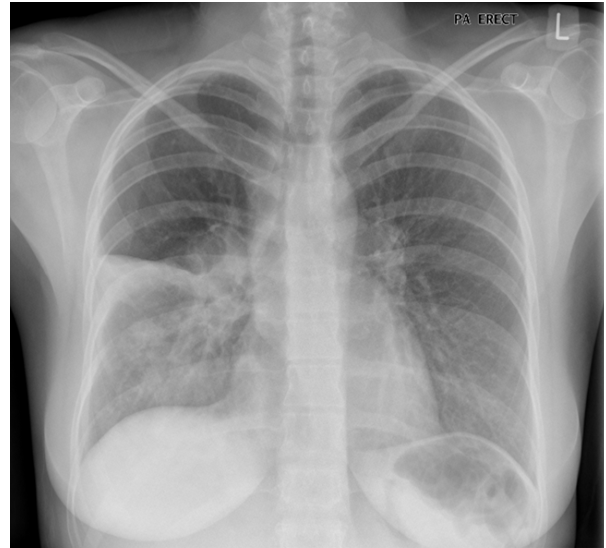
Figure 1. Right lower lobe consolidation in a patient with known chronic obstructive pulmonary disease (COPD): pneumonia or